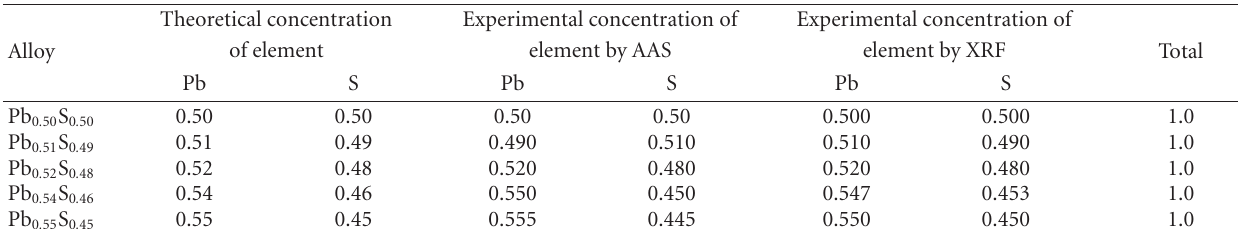
Table 1: The composition of alloys determined by AAS and XRF techniques.